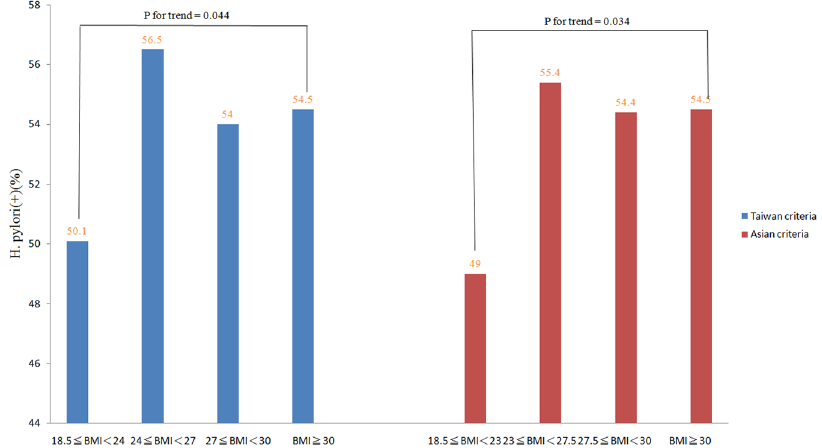
Figure 2. The prevalence of current H . pylori infection in normal, overweight and obese subjects according to Taiwan and Asian BMI criteria. The blue bars (Taiwan criteria) indicate the prevalence of H . pylori infection in normal (18.5 ≤ BMI < 24), overweight (24 ≤ BMI < 27), obese 1 (27 ≤ BMI < 30) and obese 2 (BMI ≥ 30, WHO criteria) subjects ( P for trend = 0.034). The red bars (Asian criteria) indicate the prevalence of H . pylori infection in normal (18.5 ≤ BMI < 23), overweight (23 ≤ BMI < 27.5), obese (27.5 ≤ BMI < 30), and morbidly obese (BMI ≥ 30) subjects ( P for trend = 0.044).